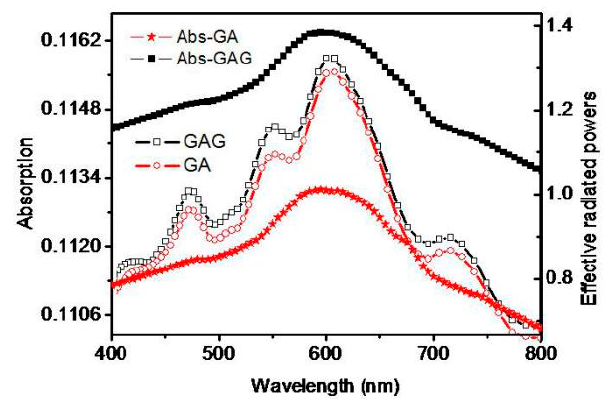
Figure 10. The absorption spectrum and the effective radiated powers of GA and GAG.